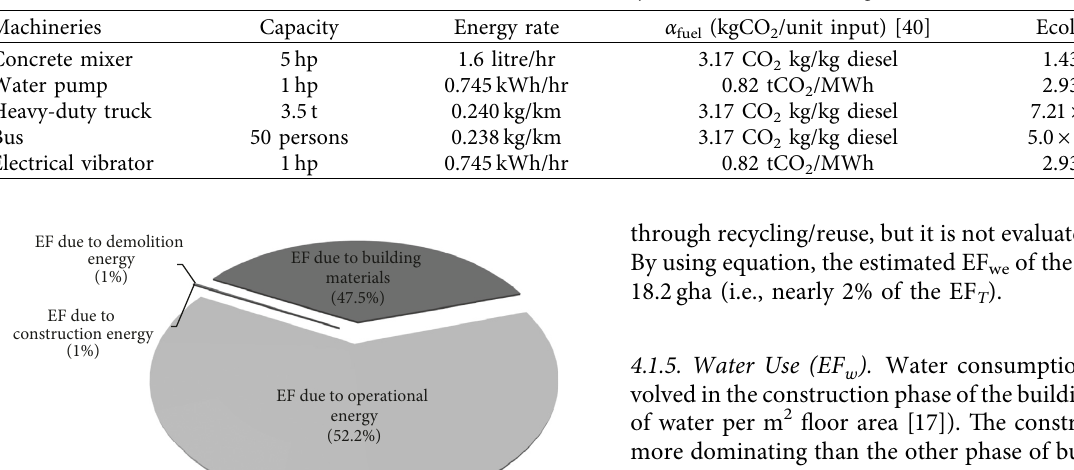
Table 9: Construction machinery use in the case